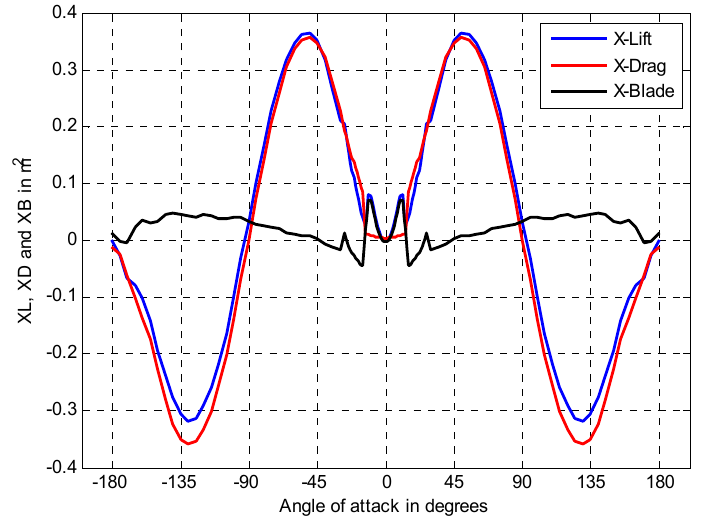
Figure 9. Lift, drag and tangential reactance variations as functions of the angle of attack.